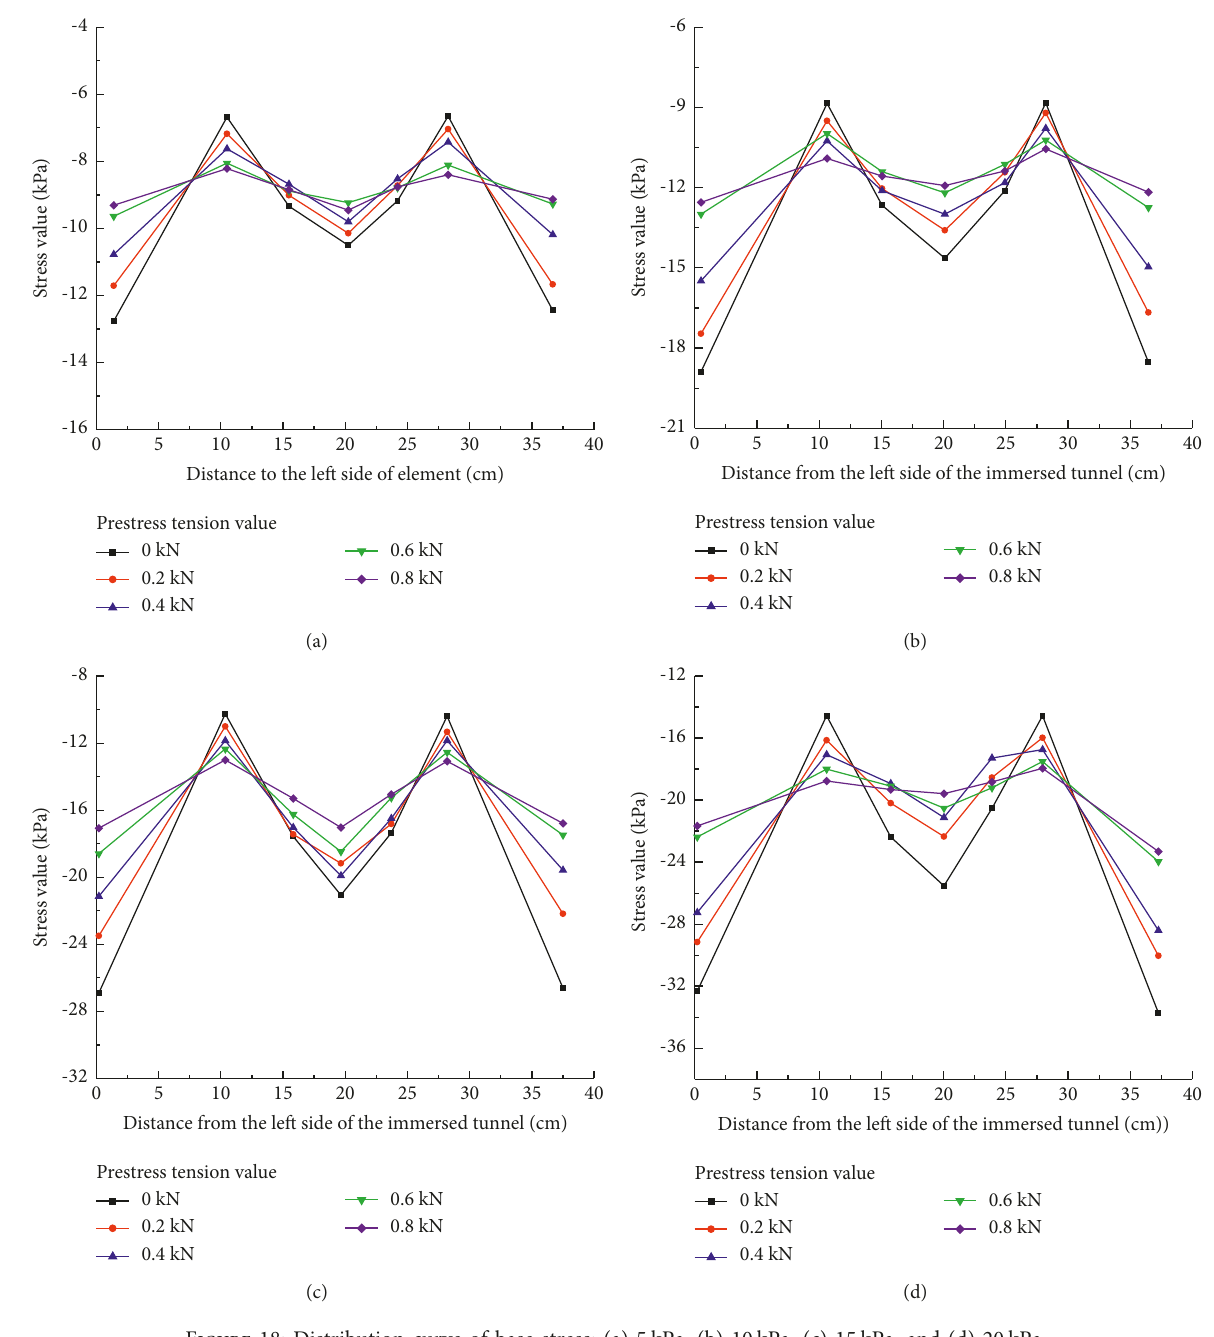
Figure 18: Distribution curve of base stress: (a) 5 kPa, (b) 10kPa, (c) 15kPa, and (d) 20